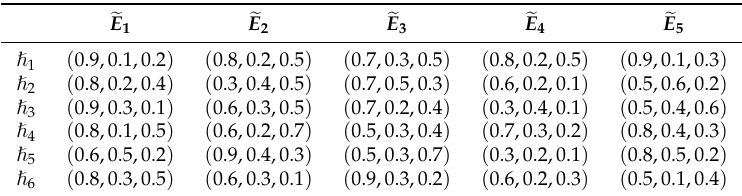
Table 4. A tabular representation of FOFSs for (cid:101) E